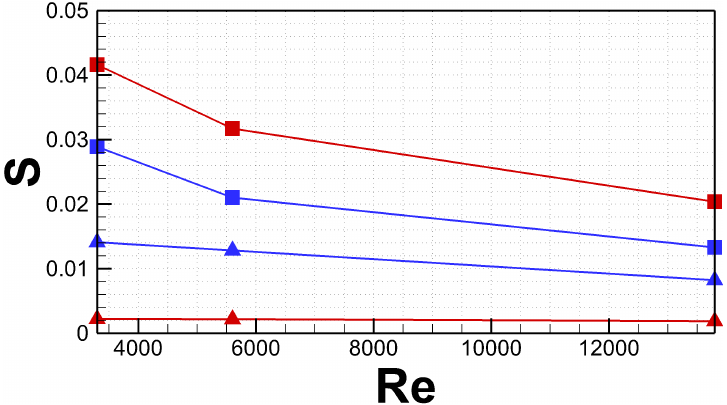
Figure 3. Integral values ( S ) of: ( (cid:4) ) Velocity gradient production term, ( (cid:78) ) micropolar production term; (red line) m = 0.2, (blue line) m = 0.9 plotted along Re = 3300,5600 and 13,800.